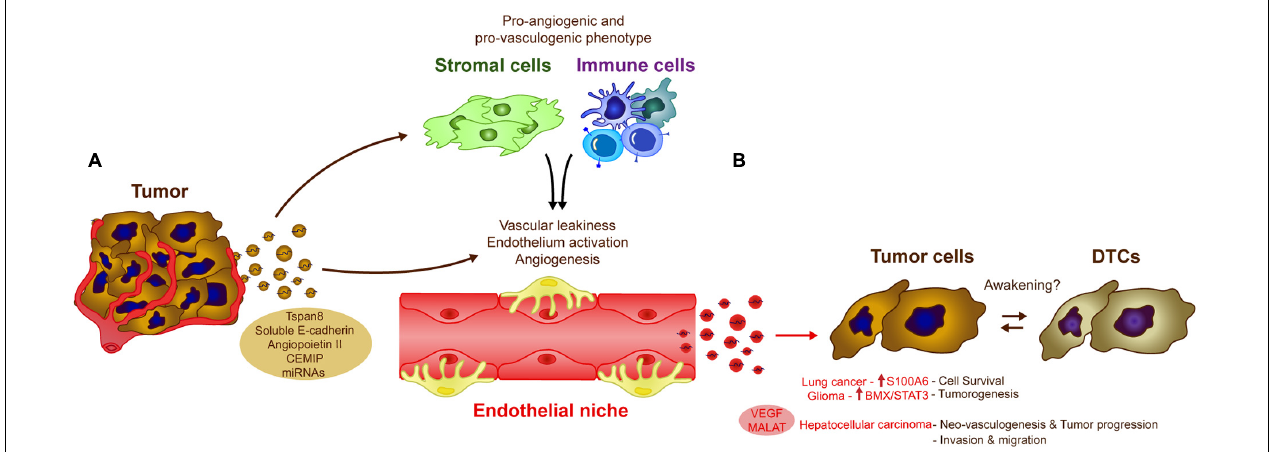
FIGURE 3 | Influence of endothelial cell-derived EVs in tumor cells. The crosstalk between tumor and endothelial cells via EVs modulate several biological processes that could influence DTC awakening. (A) Tumor-derived exosomes induce vascular leakiness, endothelium activation and angiogenesis, key processes in metastasis development, directly by transferring different molecules and miRNAs to the endothelial cells or indirectly by affecting other cell populations in the microenvironment as stromal or immune cells. (B) The altered endothelium is also capable of generating EVs, which induce pro-metastatic features (e.g., cell survival, neoangiogenesis, invasion) in a variety of cancer types (as Lung cancer, glioma, or hepatocellular carcinoma), these signals may be similar to those involved in tumor DTC